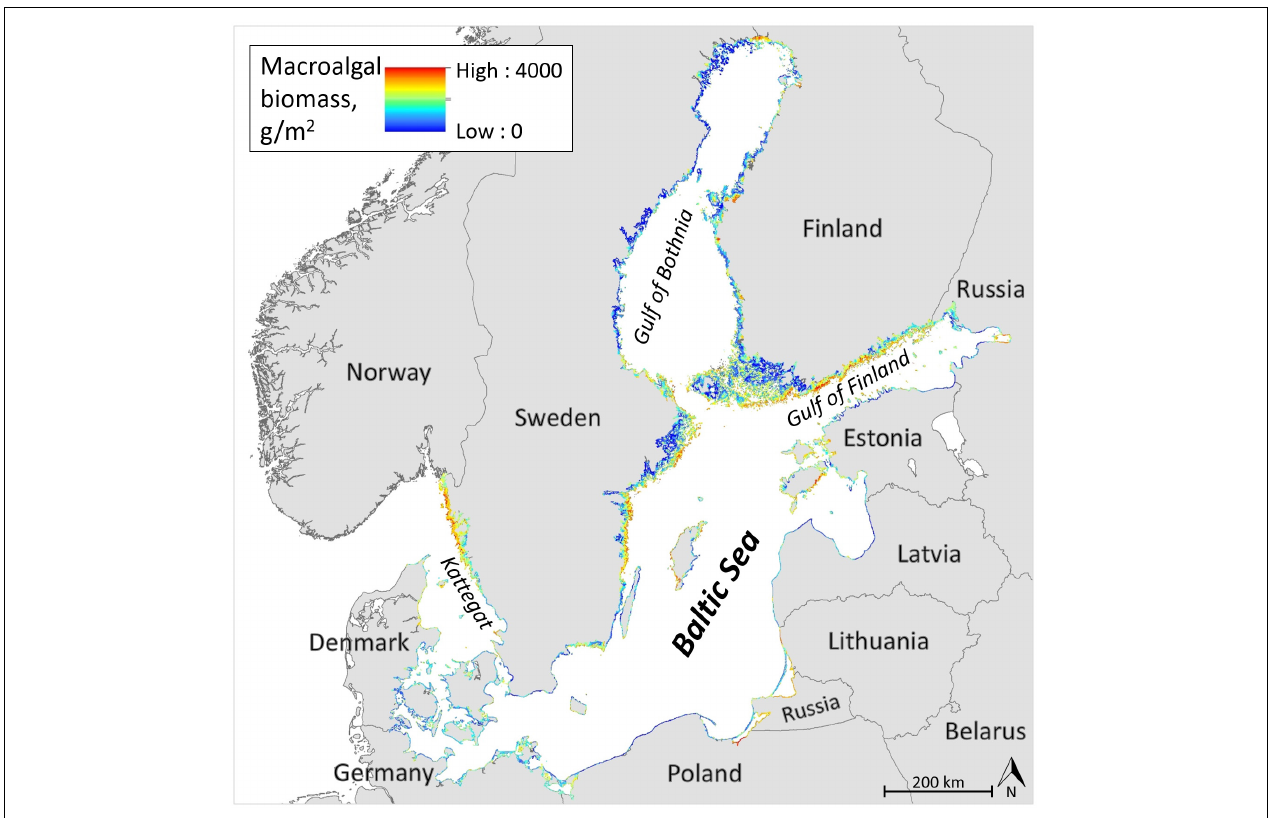
FIGURE 4 | Monthly beach wrack growth production potential in the Baltic Sea by assessing macroalgal biomass